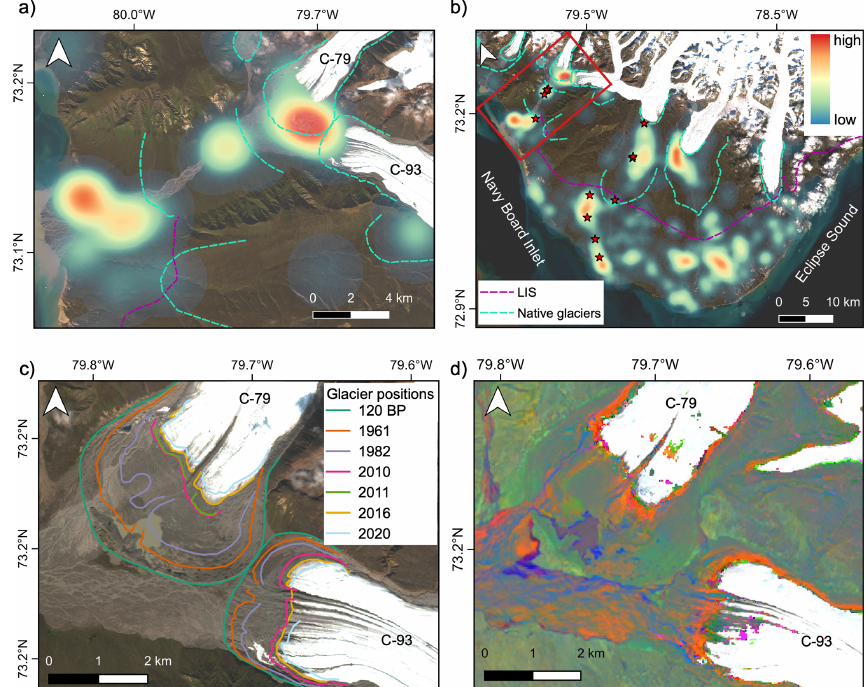
Figure 2. (a) Spatial point density of lake locations in the Qarlikturvik Valley. (b) Spatial point density of lakes in the southern plain of Bylot Island. The dashed blue line shows former limits of local mountain glaciations. The dashed purple line shows the limit of the Laurentide Ice Sheet (LIS) as defined by Klassen (1993). The red stars indicate the locations of deep lakes (between 5 and 21m) studied in Coté and Pienitz (2010). (Background: Sentinel-2 (ESA) image courtesy of the Copernicus Open Access Hub.) (c) Glacier terminus positions from 120calBP to present and (d) tasseled cap transformation images obtained from Google Earth Engine (Gorelick et al., 2017). The accumulation and movement of sediments in the outwash plain and at the glacier front are represented by red and orange colours in the images (dry and unvegetated areas; TC brightness). Wetter areas, such as eroding cliff, lake shore or river channel, are shown in blue (high TC wetness). Vegetated areas are distinguished by teal and yellow colours (TC